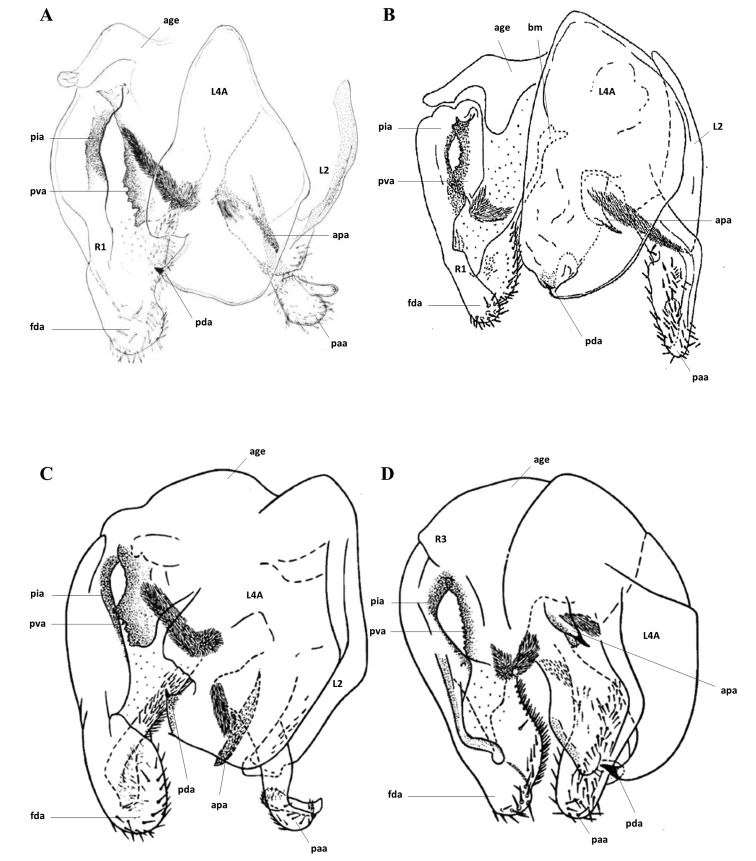
Genitalia: AGalepsus (S.) bipunctatus (modified from Kaltenbach 1996) BGalepsus (S.) denigratus (modified from Beier 1957) CGalepsus (S.) bipunctatus (modified from Beier 1954) DGalepsus (S.) denigratus (modified from Beier 1954). No scale. For abbreviations see Brannoch et al. (2017) and the text.